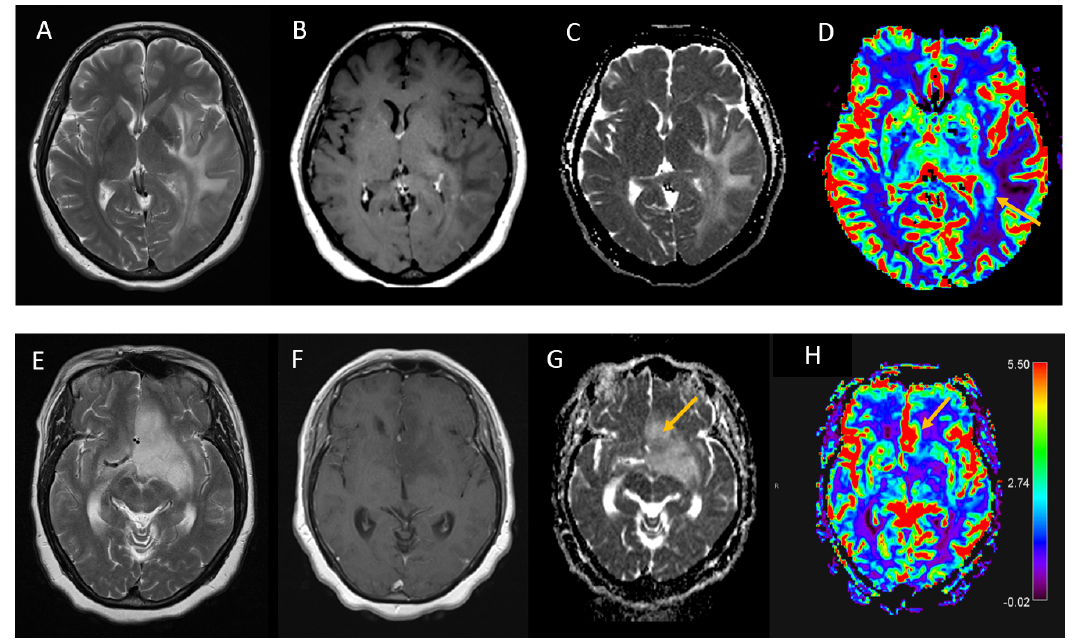
Figure 2. T2-weighted and gadolinium-enhanced T1-weighted images, ADC maps and dynamic susceptibility contrast-enhanced (DSC) imaging-derived rCBV maps in two individuals with WHO grade 4 IDH wild-type glioblastoma ( A – D ) and WHO grade 3 IDH1 mutant diffuse astrocytoma ( E – H ) showing elevated tumour perfusion (arrows).